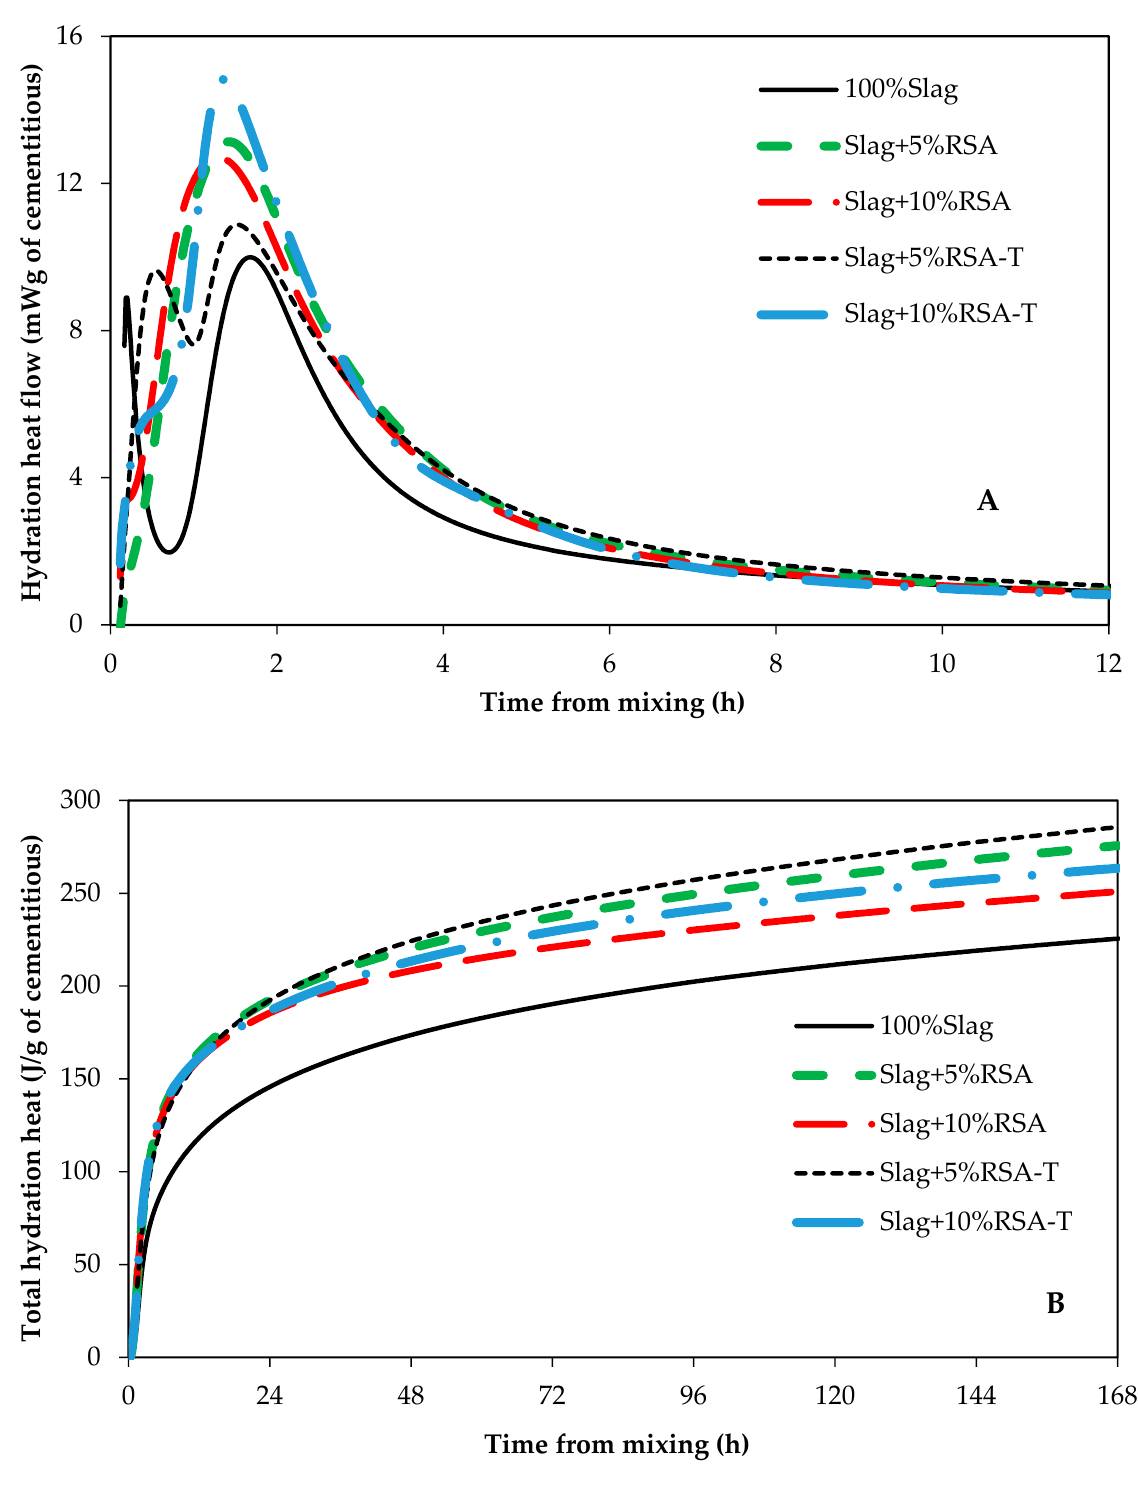
Figure 4. Hydration heat of samples containing rice straw ash. ( A ) heat flow, and ( B ) total hydration heat.